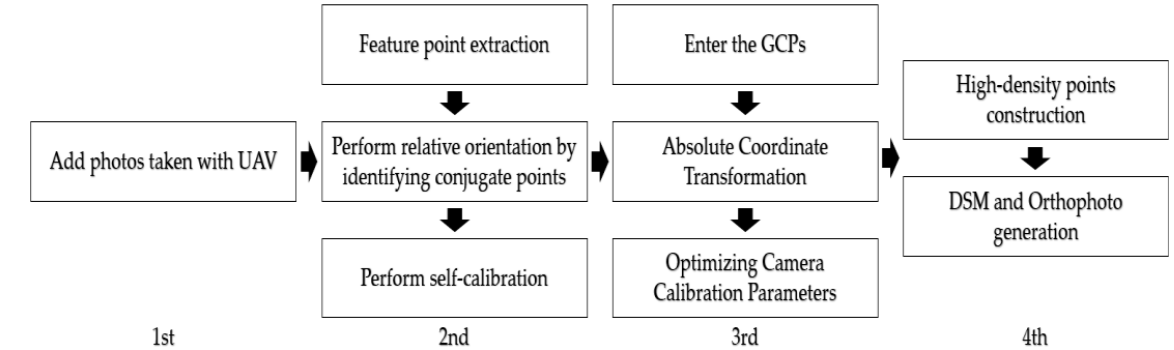
Figure 3. Image processing of UAV data.